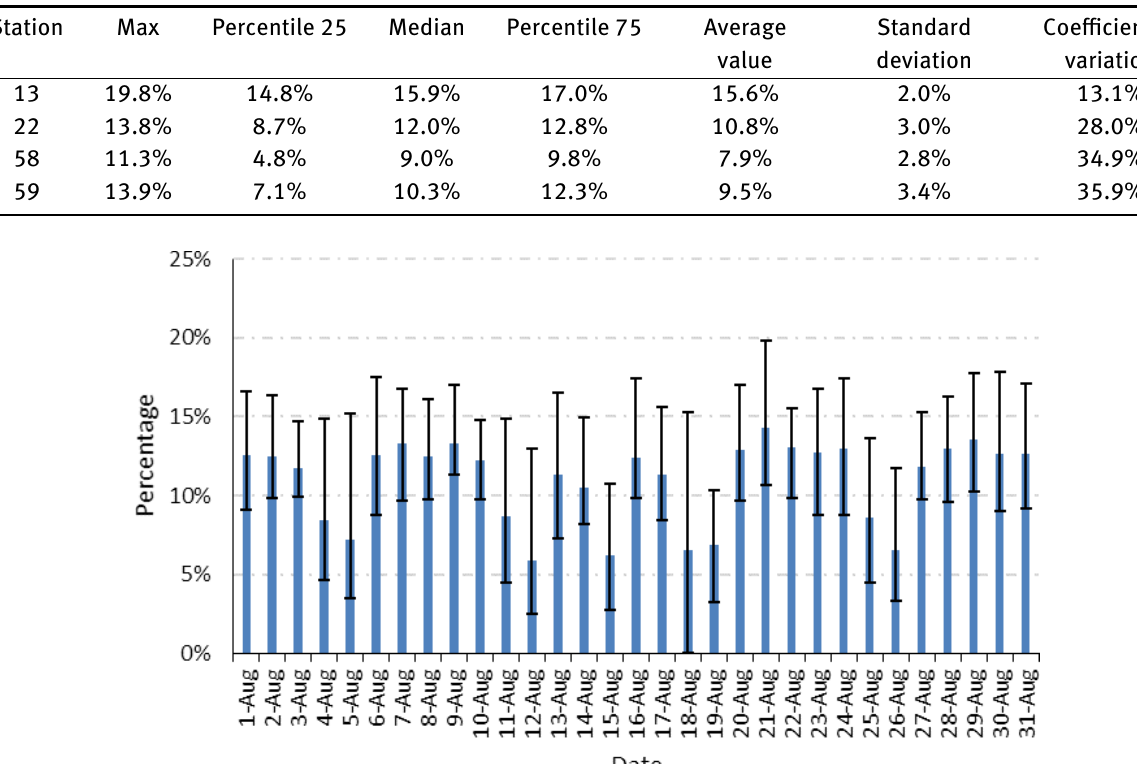
Table 7: Descriptive statistics concerning daily shares in the traflc of overloaded category 11 vehicles